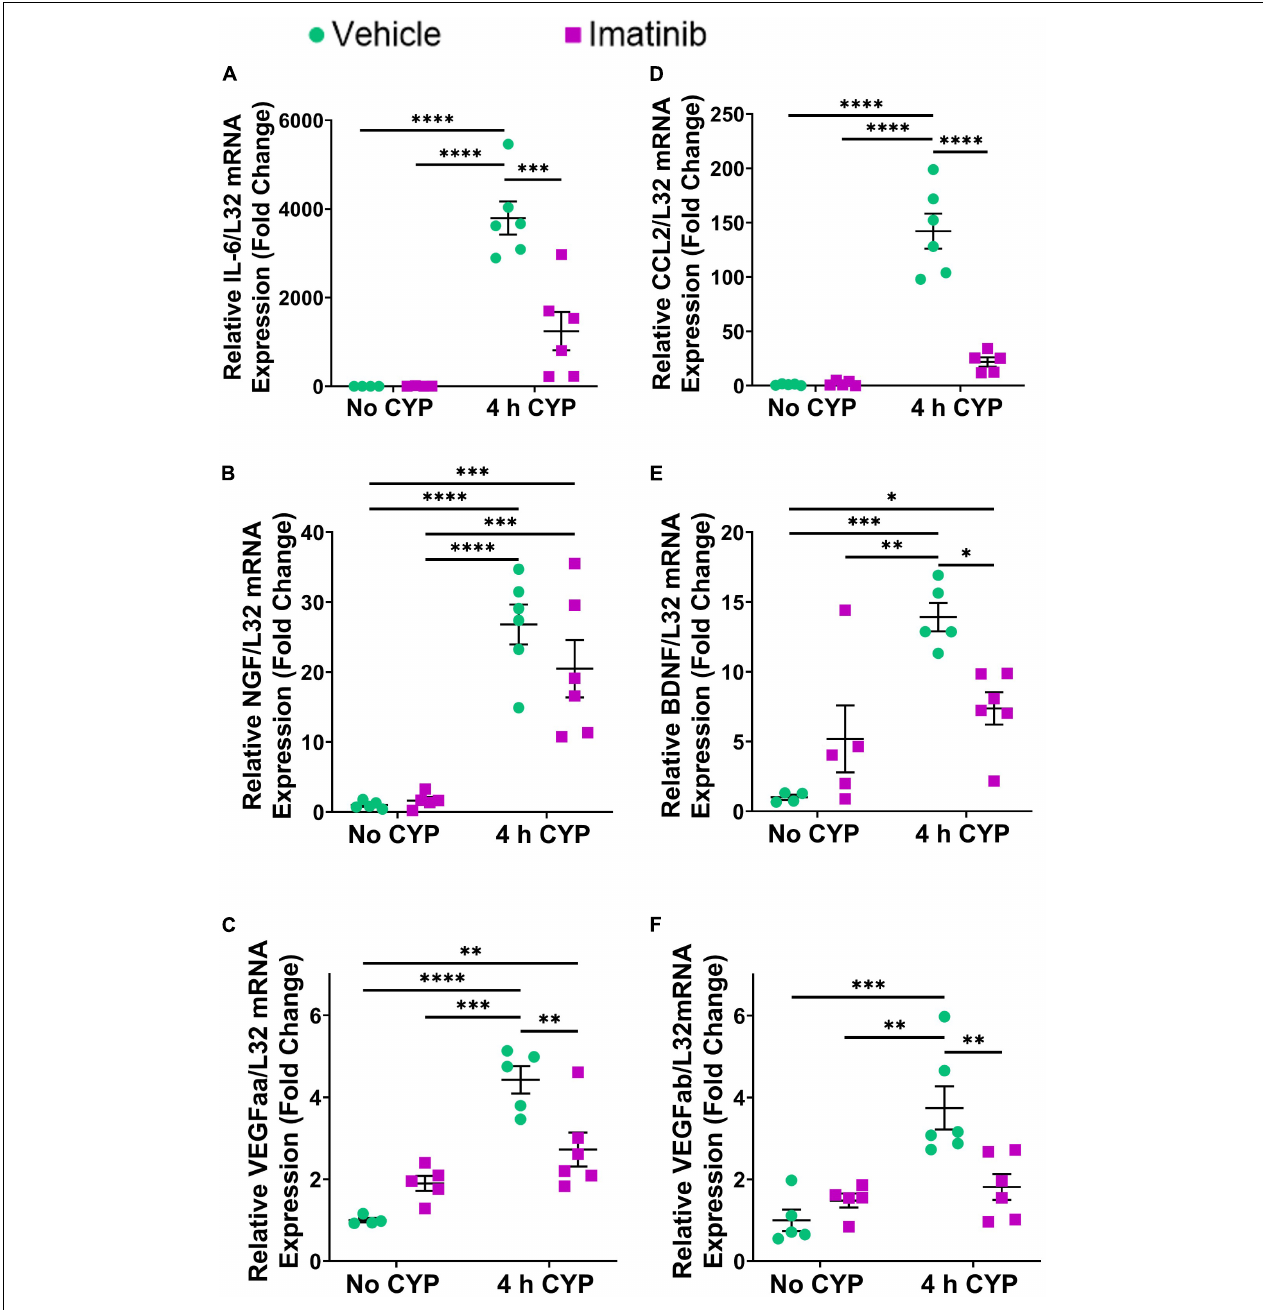
FIGURE 2 | Oral gavage of imatinib mesylate significantly affects inflammatory mediator mRNA transcript expression in the lamina propria (LP) of the urinary bladder in an acute (4 h) cyclophosphamide (CYP)-induced cystitis female mouse model. Acute (4 h) CYP treatment (200 mg/kg, i.p.) significantly (0.0001 ≤ p ≤ 0.001) increased (A) IL-6 (3794.4-fold), (B) NGF (26.8-fold), (C) VEGFaa (4.4-fold), (D) CCL2 (142.2-fold), (E) BDNF (13.9-fold), and (F) VEGFab (3.7-fold) mRNA transcript expression in the bladder LP in female mice pre-treated with vehicle (water) via gavage, compared to vehicle (water gavage, no CYP) control. Imatinib prevention (250 mg/kg, 5 days, 1X/day) via oral gavage significantly (0.0001 ≤ p ≤ 0.05) decreased (A) IL-6 (3.1-fold), (C) VEGFaa (1.6-fold), (D) CCL2 (6.5-fold), (E) BDNF (1.9-fold), and (F) VEGFab (2.1-fold), but did not affect (B) NGF, mRNA transcript expression in the bladder LP of female mice with 4 h CYP-induced cystitis. mRNA transcripts were measured by real time qRT-PCR. mRNA transcript expression was normalized to expression of the house keeping gene, L32. Transcript values are displayed as fold change values ± SEM with respect to the control group (vehicle, no CYP). n = 4–6. * p ≤ 0.05; ** p ≤ 0.01; *** p ≤ 0.001; **** p ≤ 0.0001 by two-way ANOVA with Tukey’s multiple comparisons